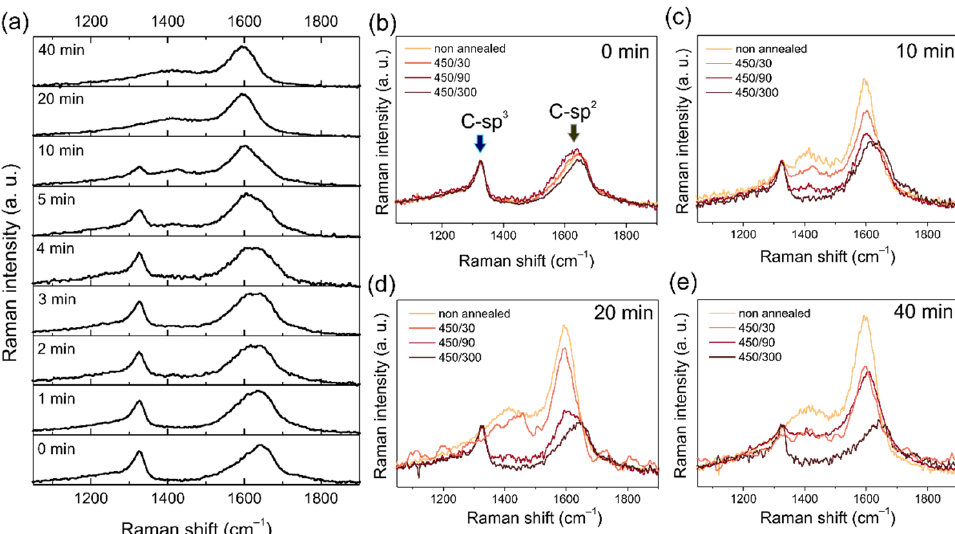
Figure 6. UV Raman spectra of laser irradiated DNDs up to 40 min ( a ). UV Raman spectra of laser treated DNDs for 0 min ( b ), 10 min ( c ), 20 min ( d ), and 40 min ( e ), without annealing, after annealing in air at 450°C for 30 min, 90 min, and 300 min. Due to the high noise level in the 450/30 spectra of 20 min ( d ) and 40 min ( e ), smoothing with the adjacent averaging method was applied.